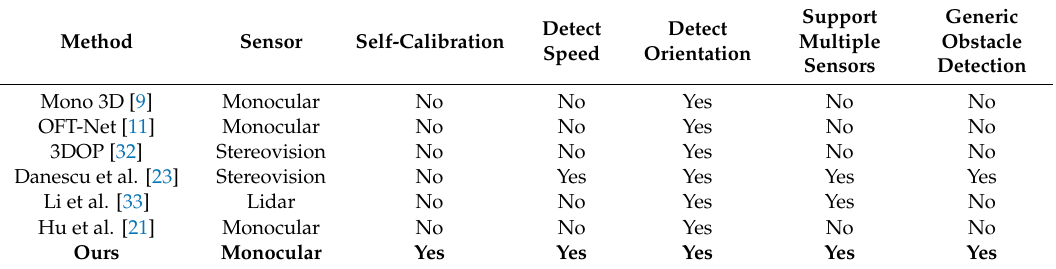
Table 7. Feature comparison with state-of-the-art obstacle detection